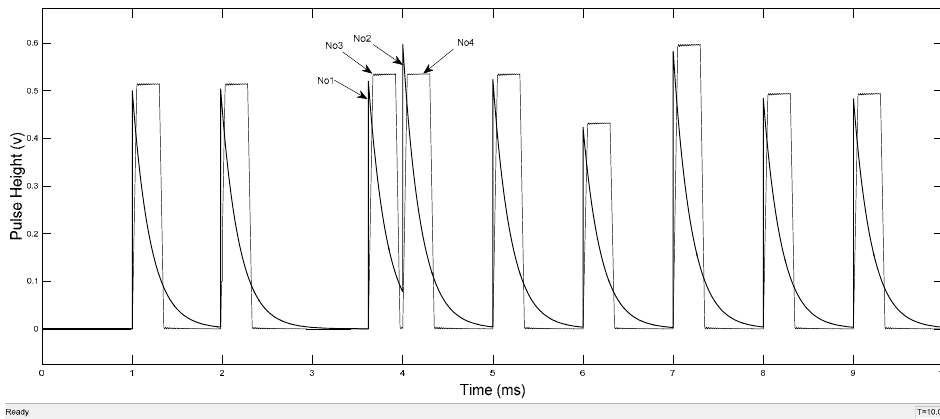
Figure 8. Detector equivalent outputs corresponding to pile-up 1.